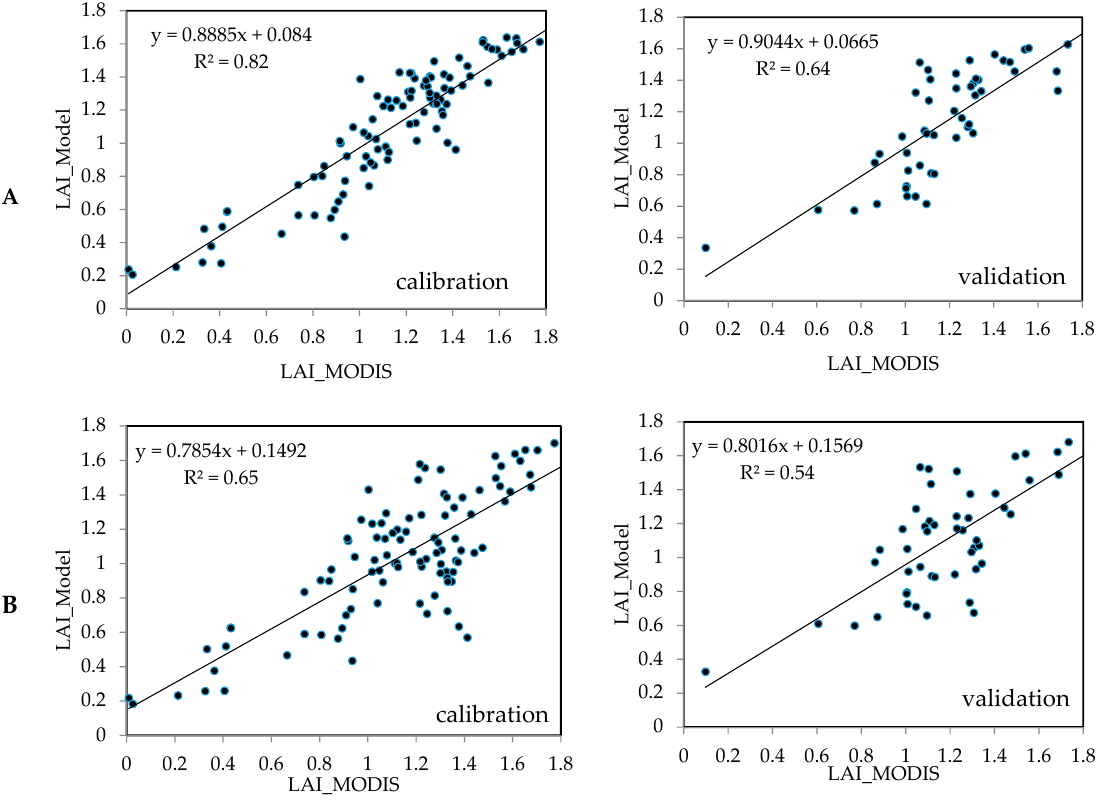
Figure 4. Calibration and validation of MODIS LAI and simulated LAI time series, ( A ) Results based on Equation (9) model; ( B ) Results based on Equation (10) model.